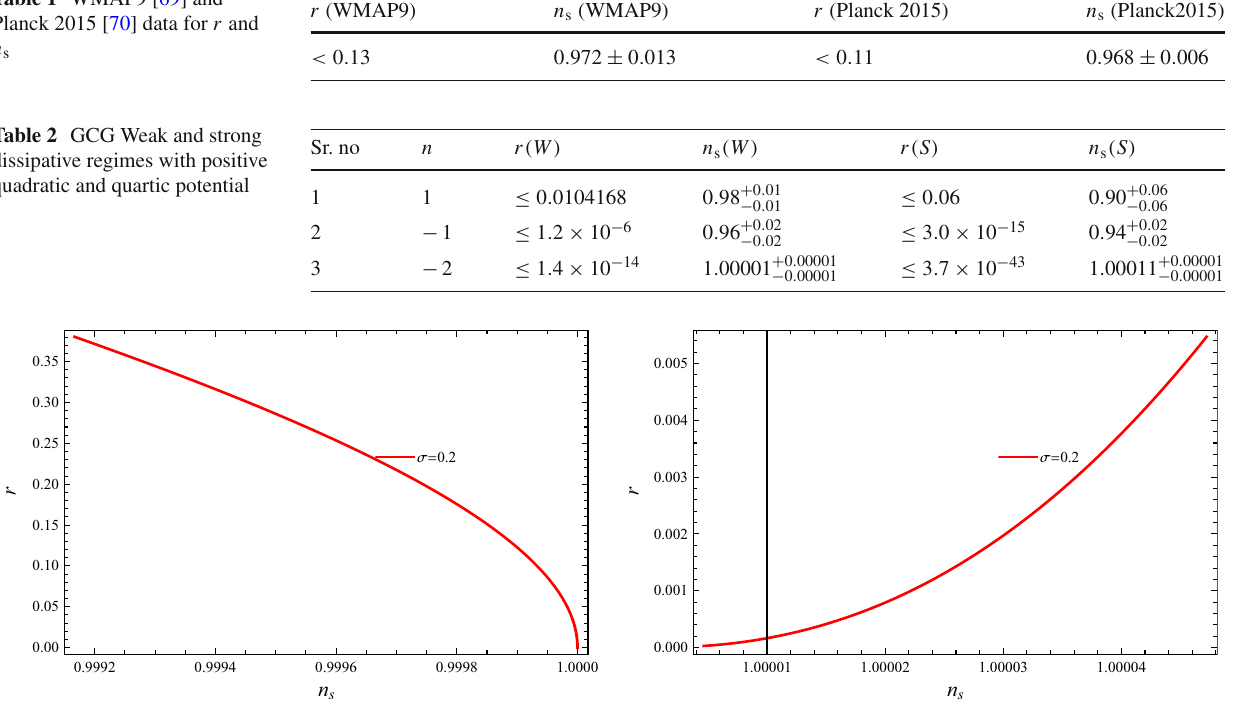
Table 2 GCG Weak and strong dissipative regimes with positive